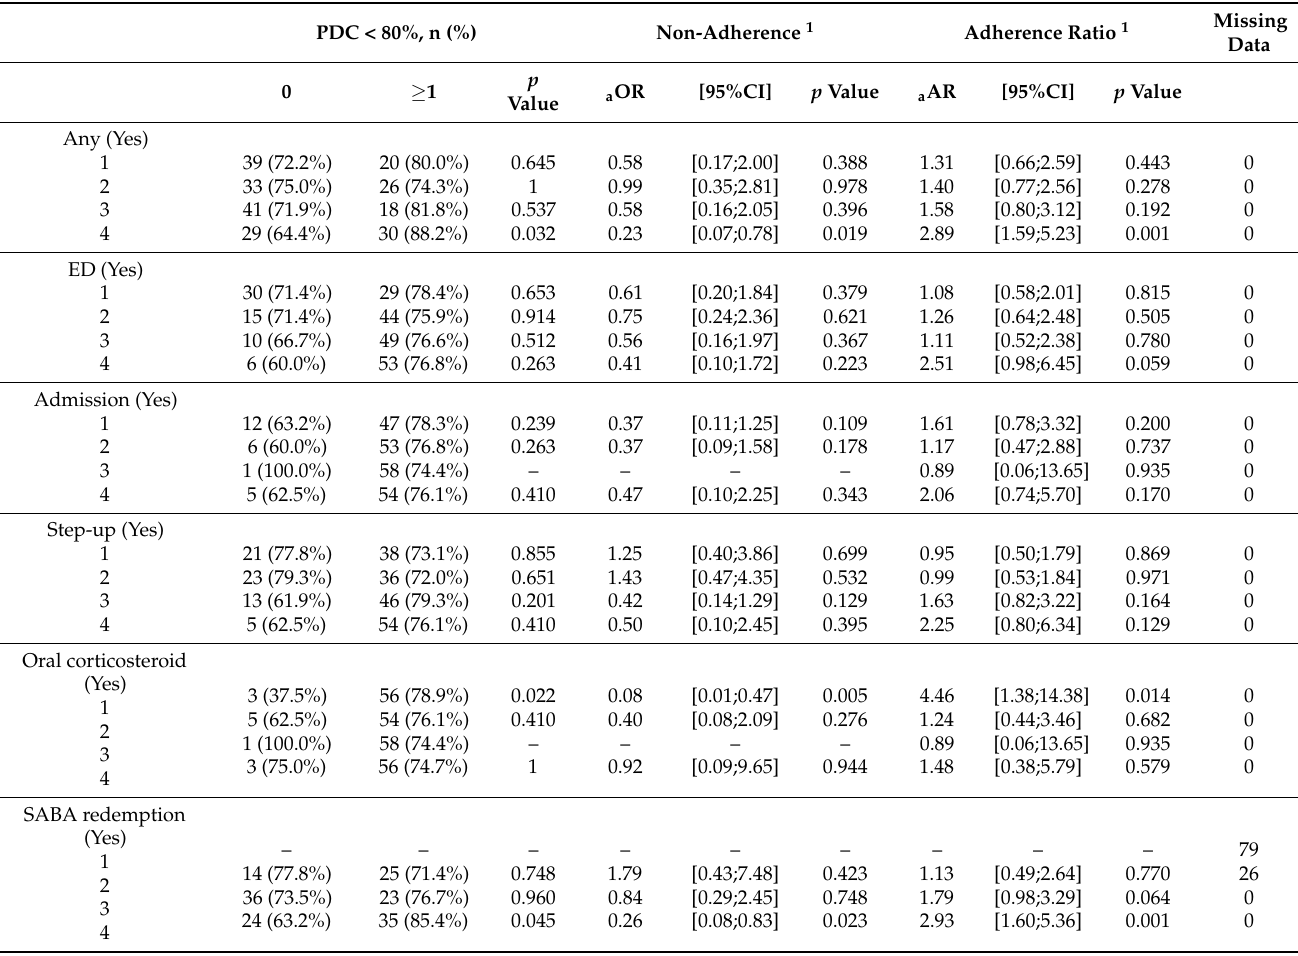
Table 4. Yearly loss of